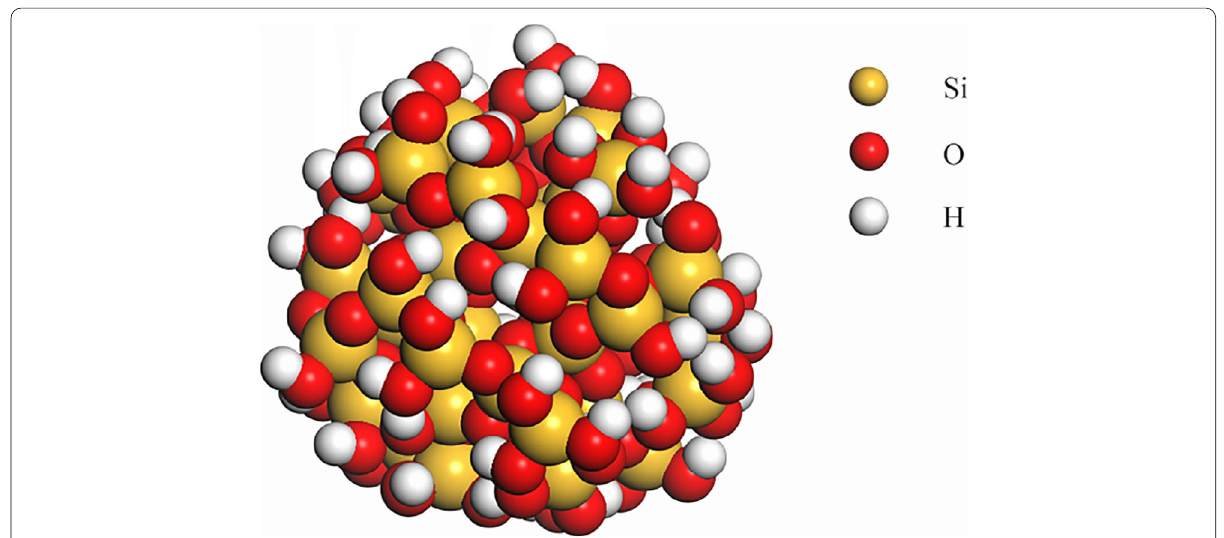
Fig. 4 Nano-SiO 2 Clusters in the